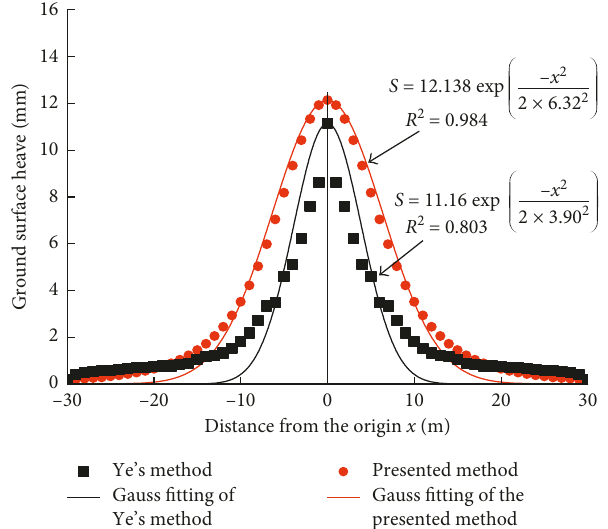
Figure 4: Ground surface heave caused by tail void grout